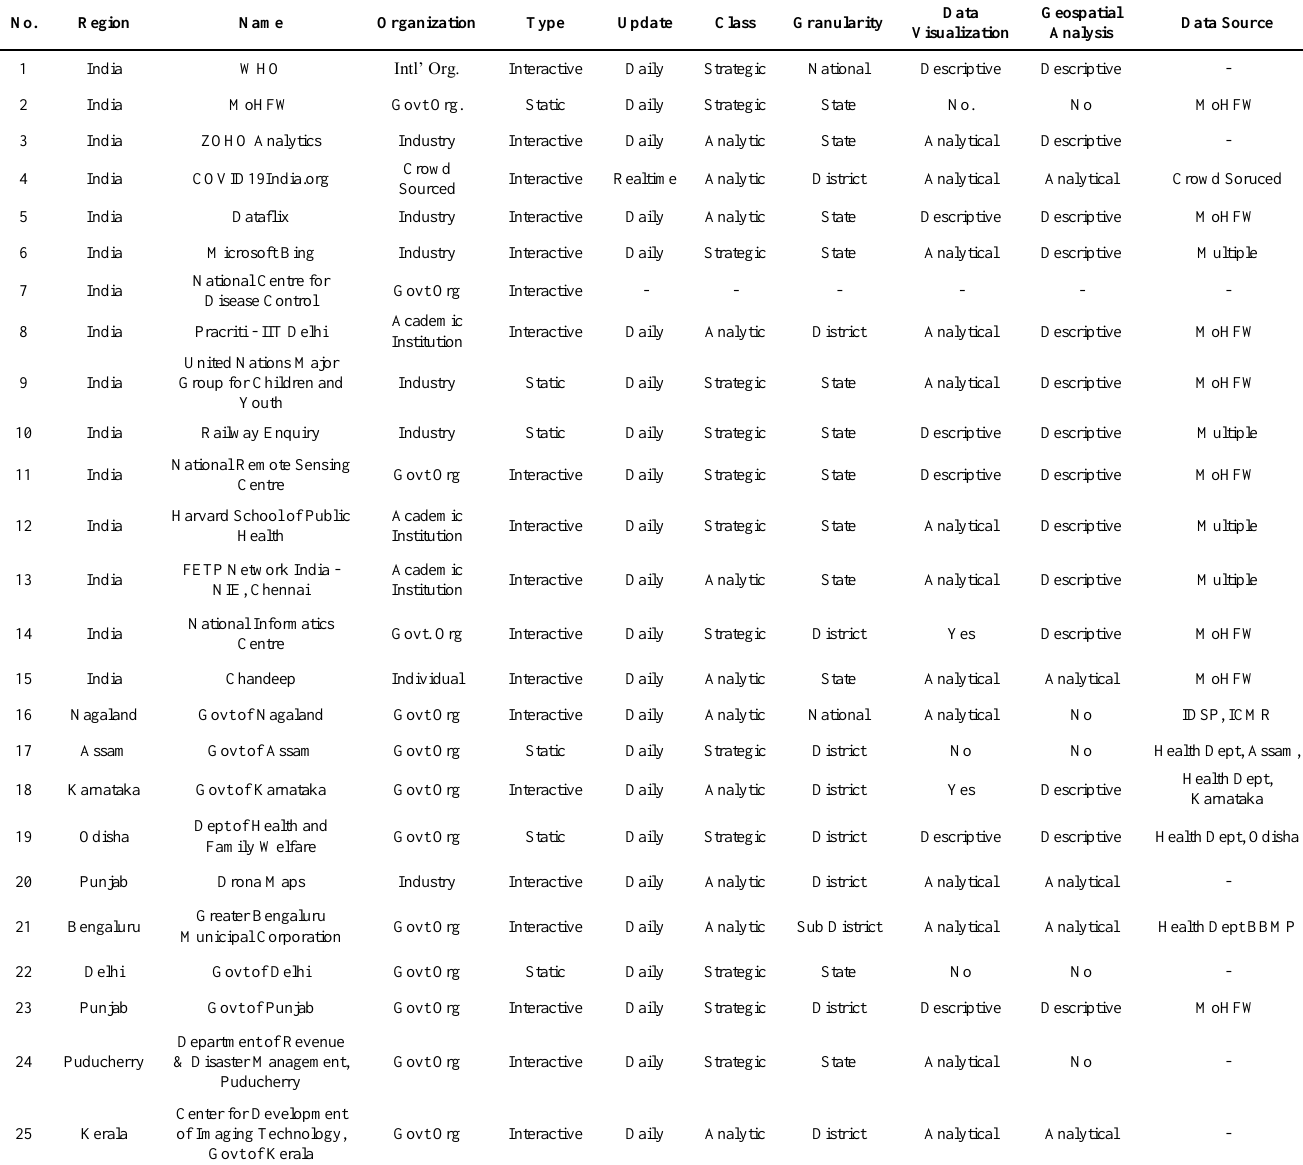
Table 1. Summary of some of the COVID-19 Dashboards developed in the Indian context